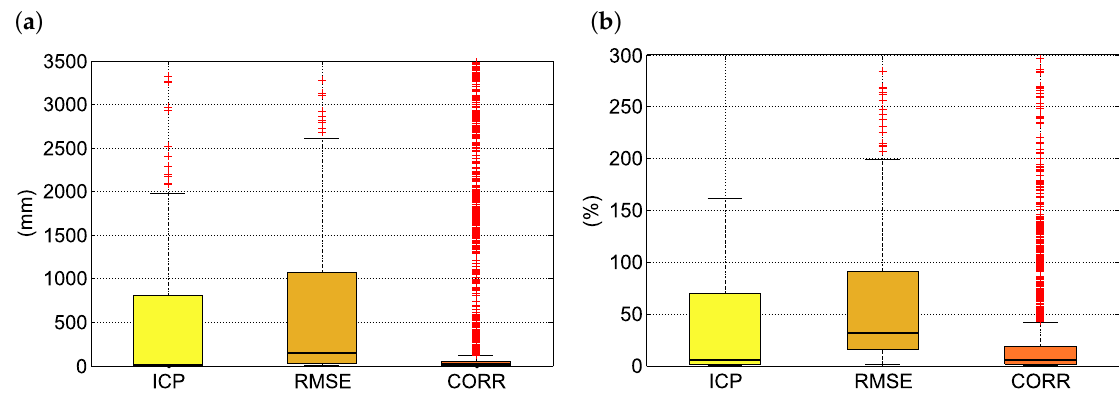
Figure 6. A boxplot visualization of the absolute ( a ) and the relative ( b ) translation error of all scan matching experiments (section Total of Table 2).